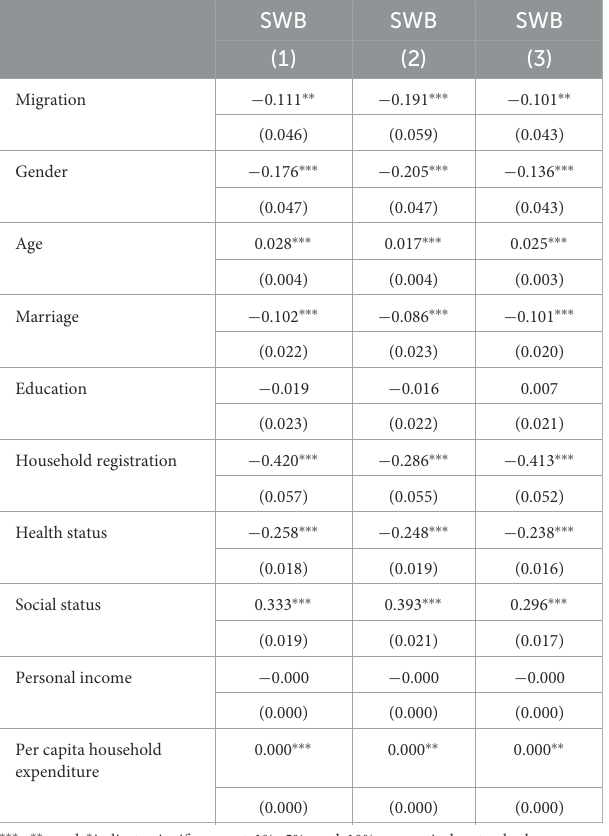
TABLE 8 Robustness regression